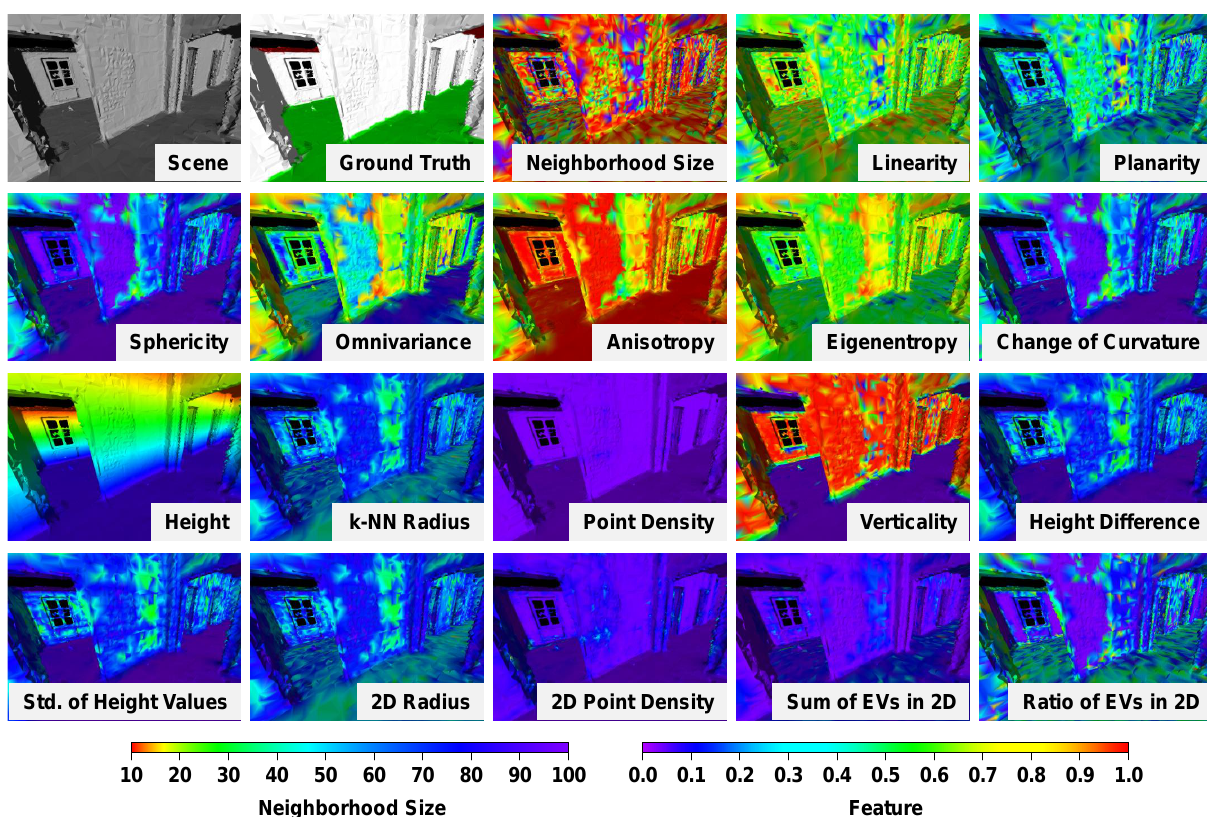
Figure 3. Visualization of the scene, the ground truth labeling, the neighborhood size, and the 17 considered features (scaled to [0 , 1] ) for the HoloLens